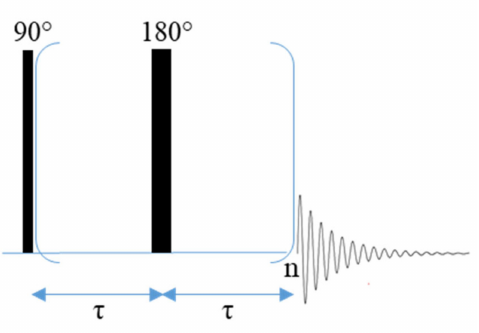
Figure 9. Carr-Purcell-Meiboom-Gill (CPMG) pulse